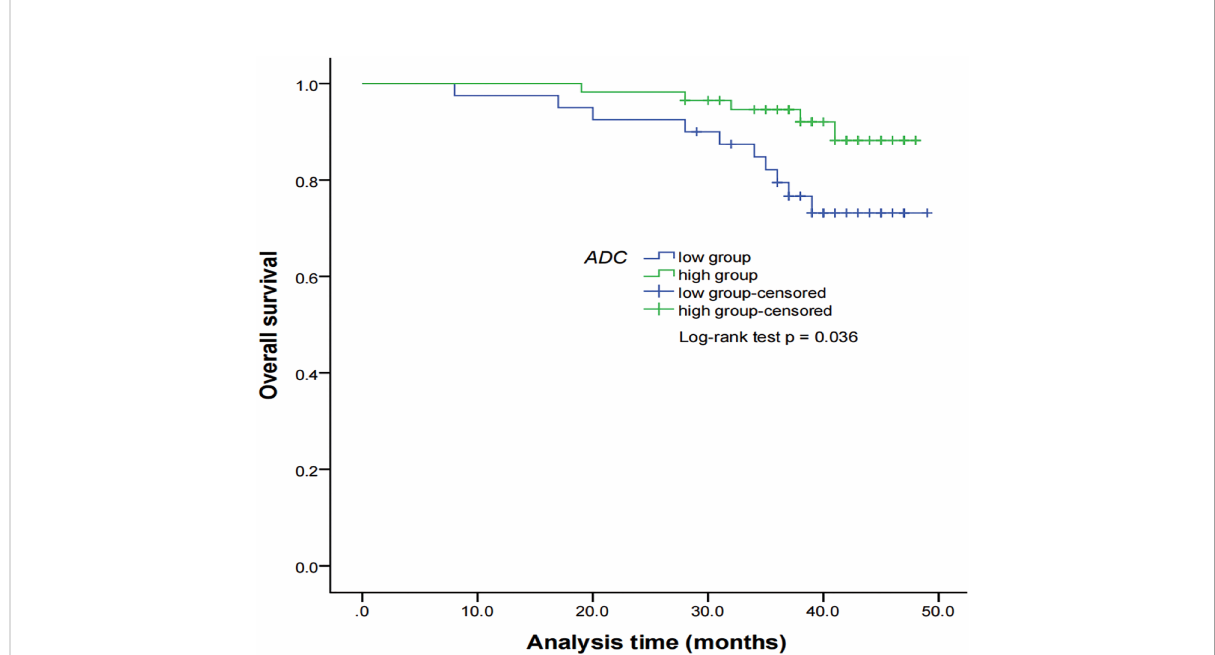
FIGURE 5 Kaplan – Meier curves of OS for NPC patients strati fi ed as the low ADC and high ADC groups. Low ADC group = patients with a primary lesion pretreatment ADC value ≤ 0.897 × 10 − 3 mm 2 /s; high ADC group = patients with a primary lesion pretreatment ADC value > 0.897 × 10 − 3 mm 2 /s. NPC, nasopharyngeal carcinoma; ADC, apparent diffusion coef fi cient; OS, overall